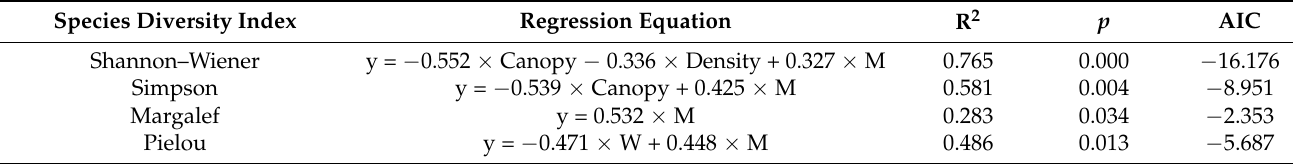
Table 5. Stepwise regression equation of species diversity